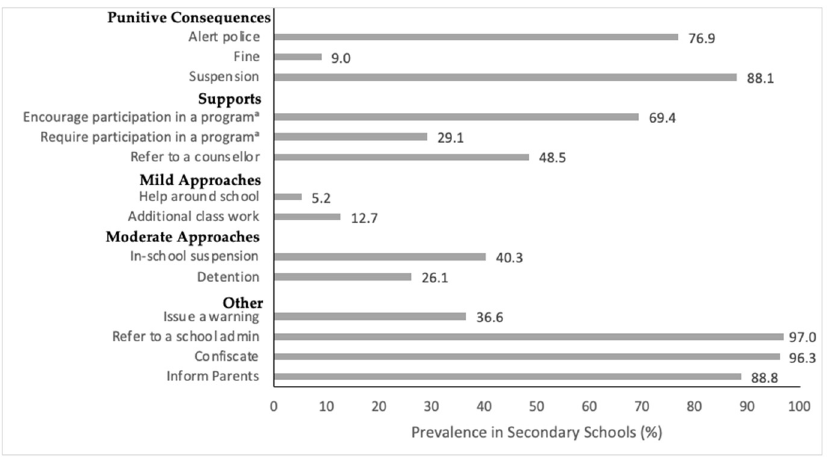
Figure 1. Percentage of Canadian secondary schools (n = 134) that indicated using various disciplinary response options for student first-offence violations of school cannabis policies in Year 7 (2018–2019) of the COMPASS study. a Assistance, education, or cessation program. Note: the question used a “check all that apply” design.